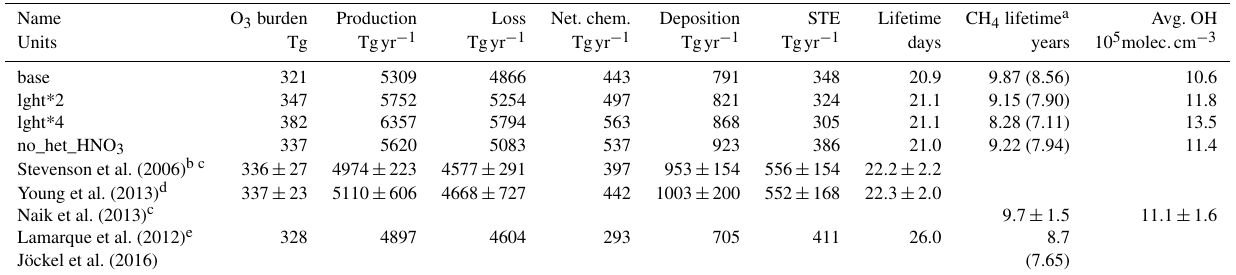
Table 5. Global tropospheric ozone budgets and tropospheric methane lifetimes of the four ECHAM-HAMMOZ simulations described in Table 4. An ozone threshold of 150nmolmol − 1 is used to denote the tropopause. For comparison, multi-model mean values from Stevenson et al. (2006), Young et al. (2013), and Naik et al. (2013) and the “GEOS5” budget terms from Lamarque et al. (2012) are also included.